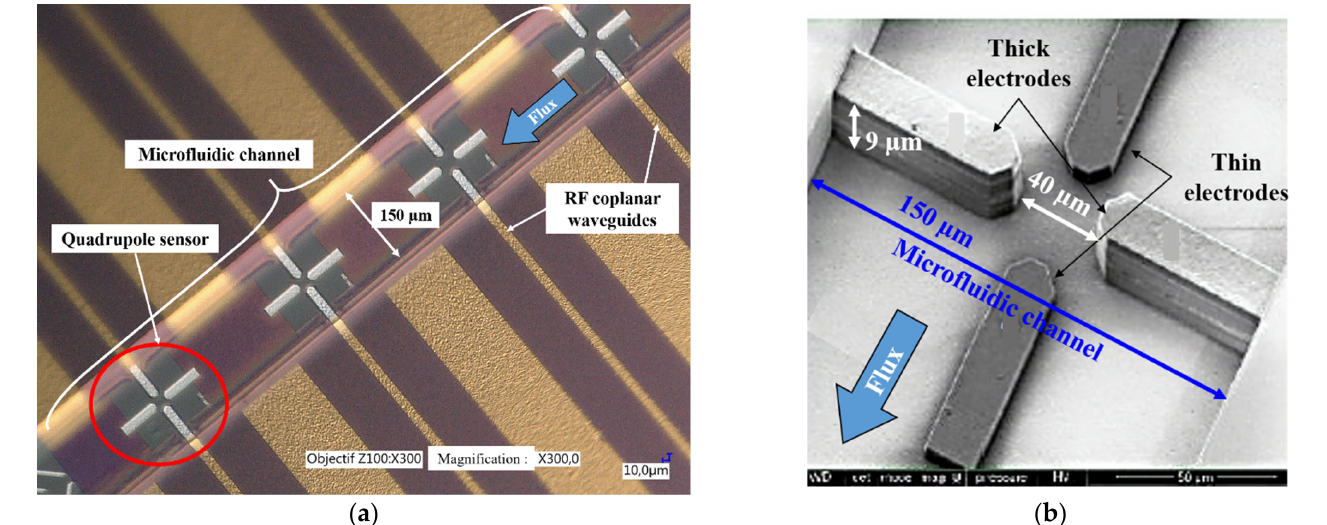
Figure 4. ( a ) Quadrupole microelectrodes sensor implemented with a microfluidic channel in BiCMOS; ( b ) Scanning Electron Microscopy (SEM) picture of a quadrupole sensor.